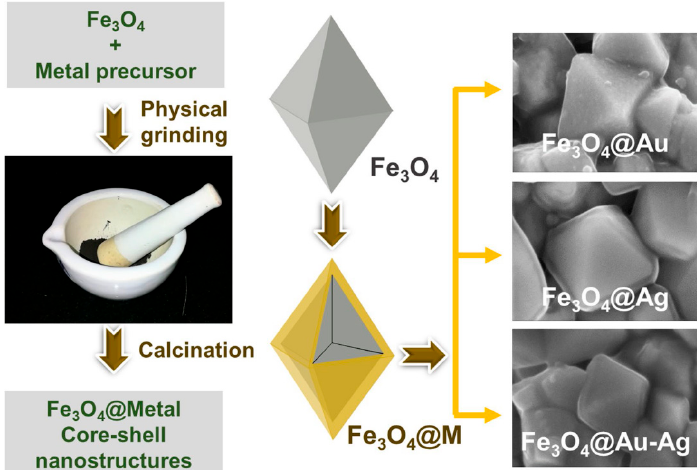
Figure 2. Schematic representation to obtain Fe 3 O 4 @M core–shell nanostructures [18]. Reproduced with permission from [Srinivasa Rao et al.], [Nature]; published by [Springer Nature], 2019.